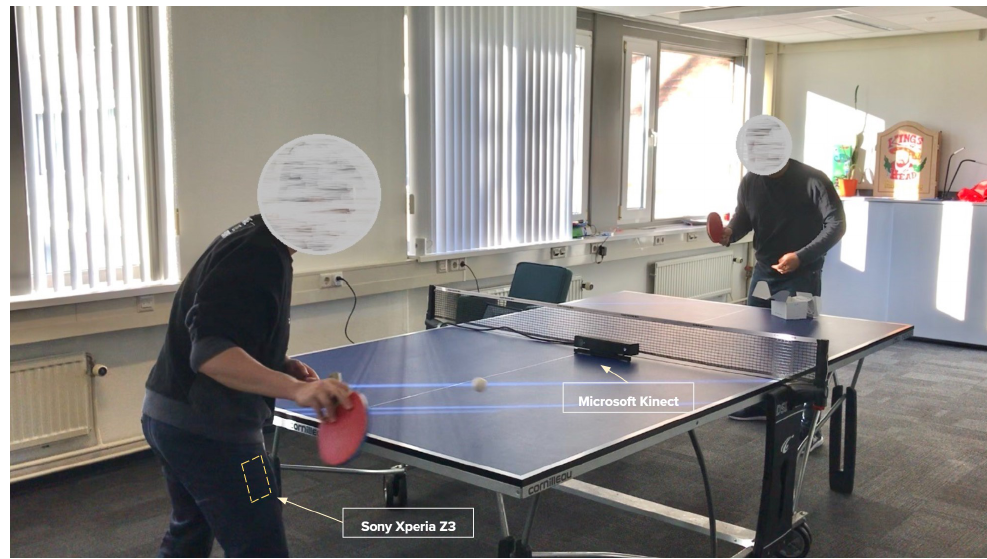
Figure 2. Data collection